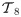
A bifurcating tree randomly generated under the uniform model, the estimated density function of the distribution of the three balance indices on T8 under the uniform model, and their percentile plot.